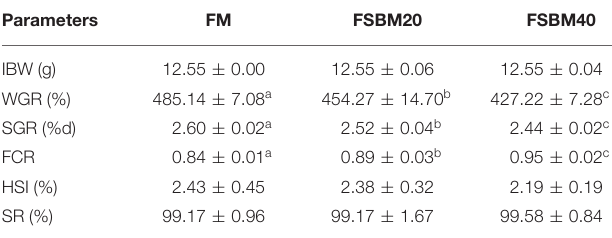
TABLE 4 | Effect of different levels of fermented soybean meal substitute for fish meal protein on the growth of pearl gentian grouper ( n = 3).